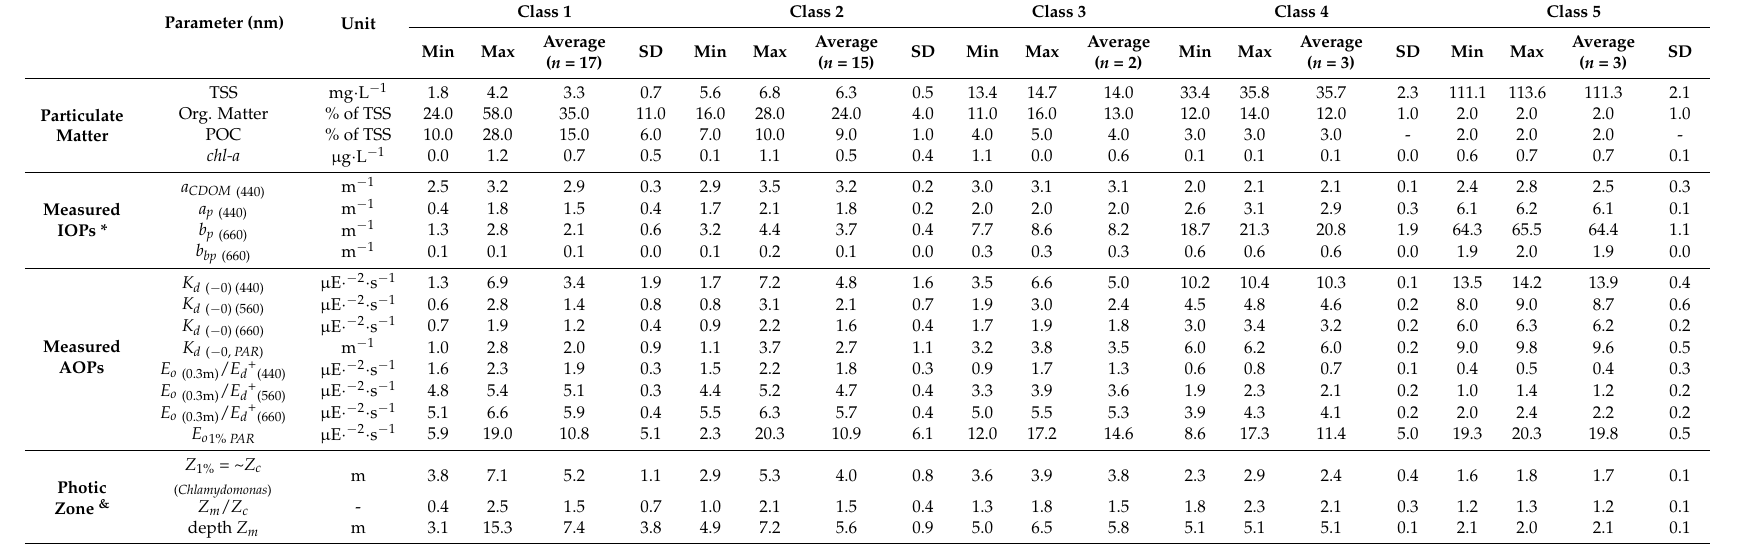
Table 2. Values of suspended solids, chl-a , and optical properties of the water classes represented in Figure 3. * IOPs for low water samples were estimated based on linear regressions established for the measurements taken during the high water period. & Parameters related to photic zone for phytoplankton productivity. Critical depth ( Z c ) and depth where scalar irradiance reaches 1% of the incoming light ( Z 1% ) are approximately the same